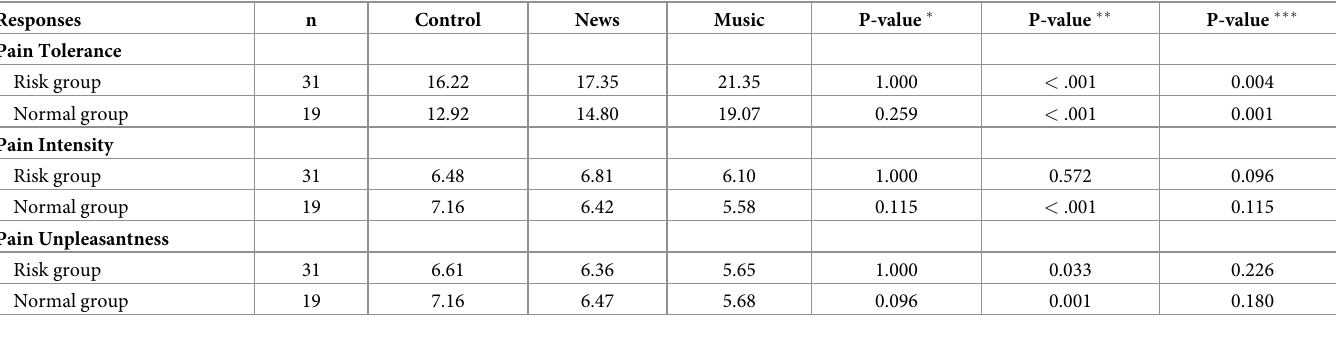
Table 5. Pairwise tests for comparing pain response between treatments for those low and high on the PASS-20.